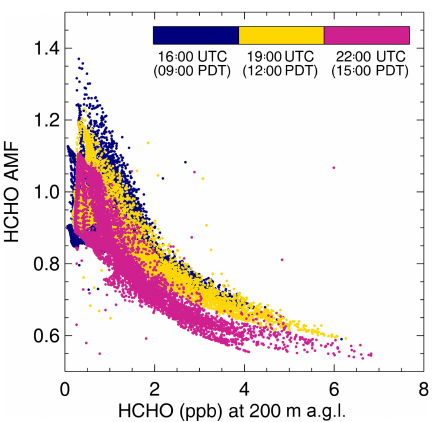
Figure 6. The relationship between the AMF and model HCHO volume mixing ratio is demonstrated. Different colors denote differ- ent times. The HCHO mixing ratio at ∼ 200ma.g.l. is plotted. The same plot with the unit of moleculescm − 3 is shown in the Supple-